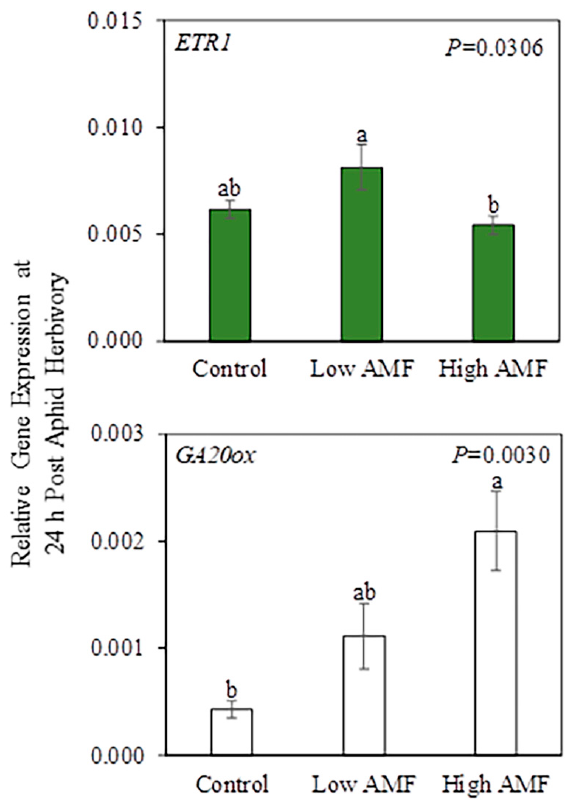
Figure 4. Relative gene expression in local leaf (green bar) and roots (white bar) after 24 h herbivory by potato aphids ( Macrosiphum euphorbiae ) on potato plants ( Solanum tuberosum ). The PA*AMF interaction was not significant in the two-factor ANOVA, but AM fungal root colonization as a main factor had a significant effect (AMF p ≤ 0.05) on ETR1 and GA20ox gene expression. Values represent the mean ± SEM (n = 6 for Control/Low AMF/High AMF). The p -values from Table S1 were used to generate this figure. Different letters indicate significant difference among groups based on the Tukey–Kramer test ( p ≤ 0.05). Control = non-mycorrhizal plants; Low AMF = plants with a low level of AM fungal root colonization; High AMF = plants with a high level of AM fungal root colonization. ETR1 = ETHYLENE RECEPTOR 1; GA20ox = GIBBERELIC ACID 20-OXIDASE.